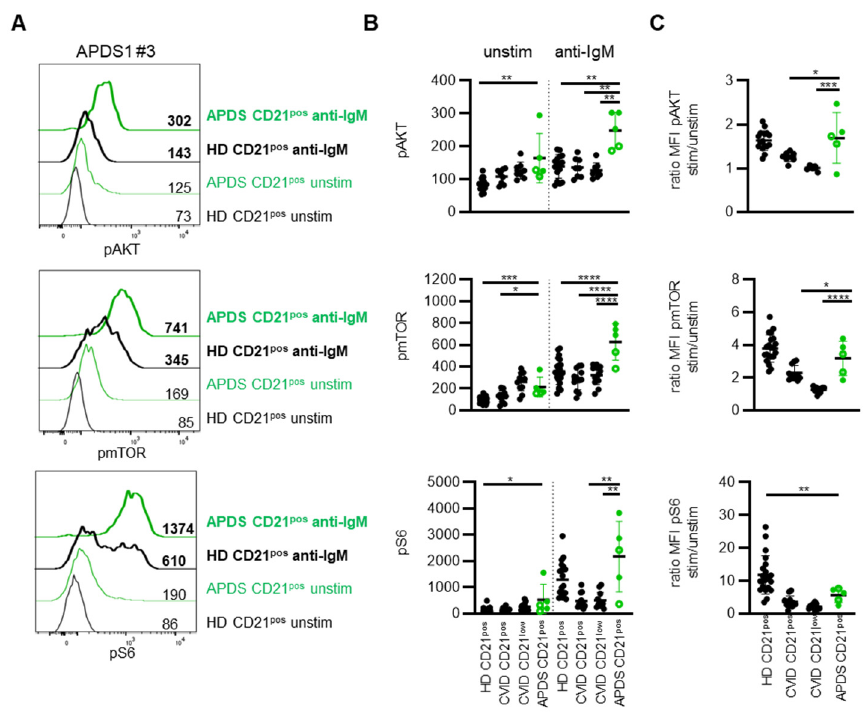
Figure 5. PI3K signaling differentiates between APDS and CVID patients. ( A ) Histogram overlays of pAKT, pmTOR and pS6 in CD21 pos B cells of one APDS patient (green) and the respective HD (black) unstimulated (normal lines) and after stimulation with anti-IgM (bold lines). ( B ) Statistics of the MFI of pAKT, pmTOR and pS6 unstimulated and after anti-IgM stimulation in CD21 pos B cells of HD, CD21 pos and CD21 low B cells of CVID patients (all depicted in black) and in CD21 pos B cells of APDS patients (green). Patients with GOF mutations in p110 δ (filled circles) and LOF mutations in p85 α (open circles) were differentiated. ( C ) Ratio of the MFI of pAKT, pmTOR and pS6 after anti-IgM stimulation and unstimulated as shown in ( B ). * p < 0.05, ** p < 0.01, *** p < 0.001, **** p <